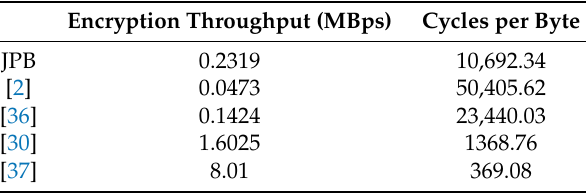
Table 7. Comparison of encryption